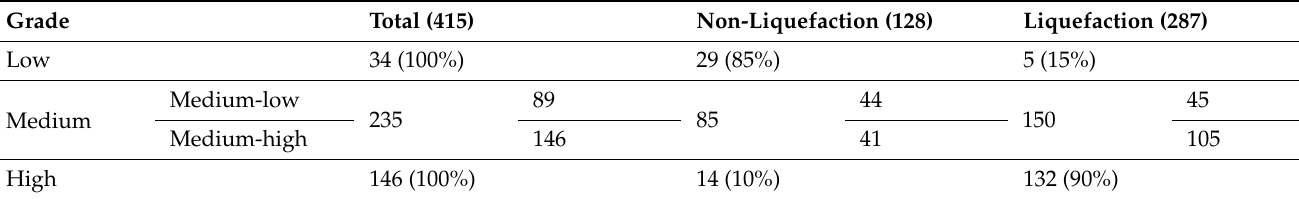
Table 8. Accuracy of evaluation for the criteria table of liquefaction potential